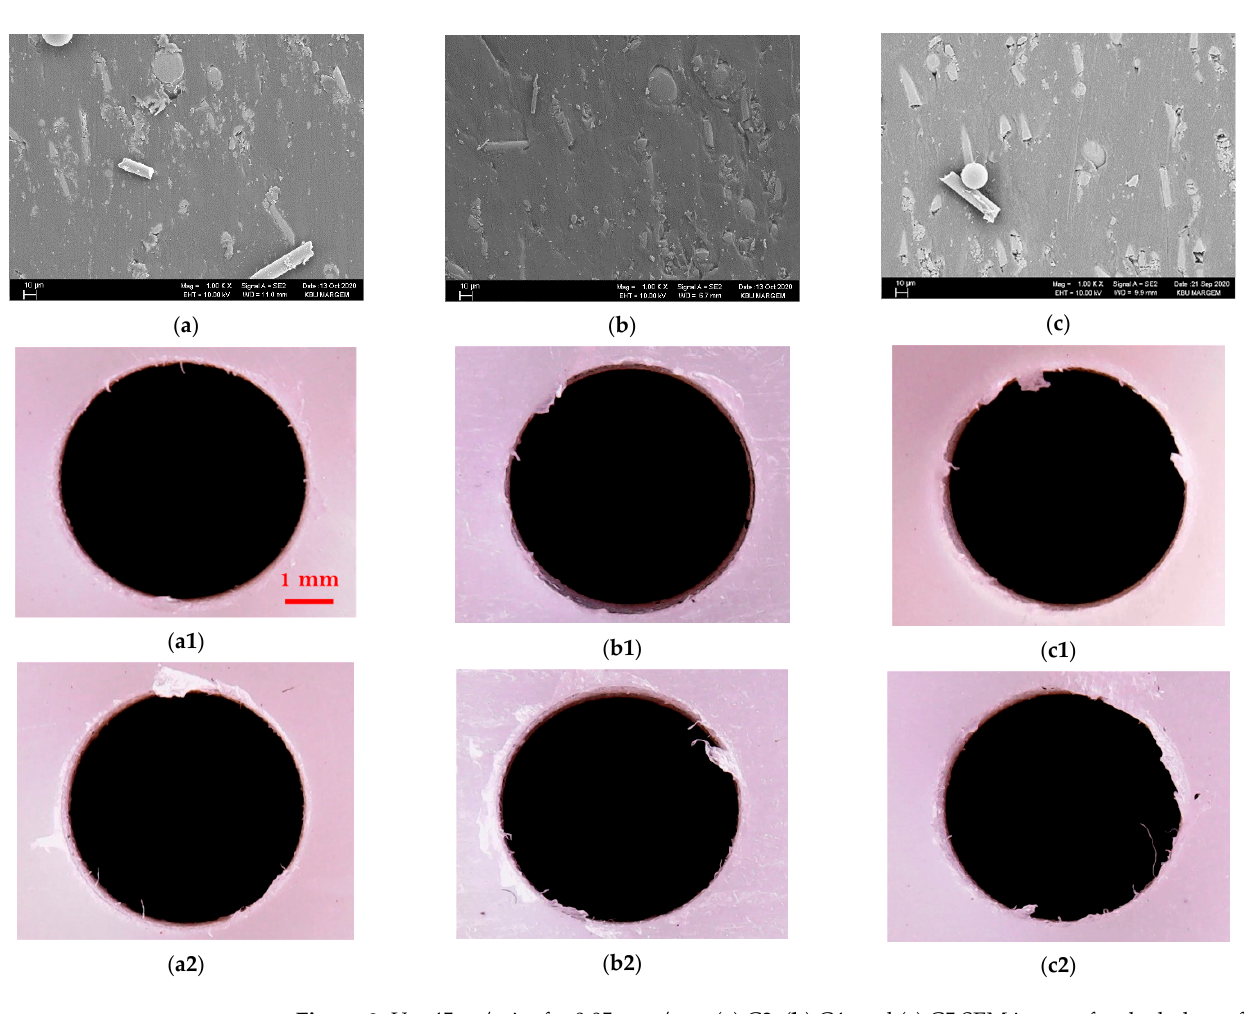
Figure 8. V = 45 m/min, f = 0.05 mm/rev: ( a ) C1 and ( b ) C2 hole surface SEM images, ( c ) C1 and ( d ) C2 hole exit images.